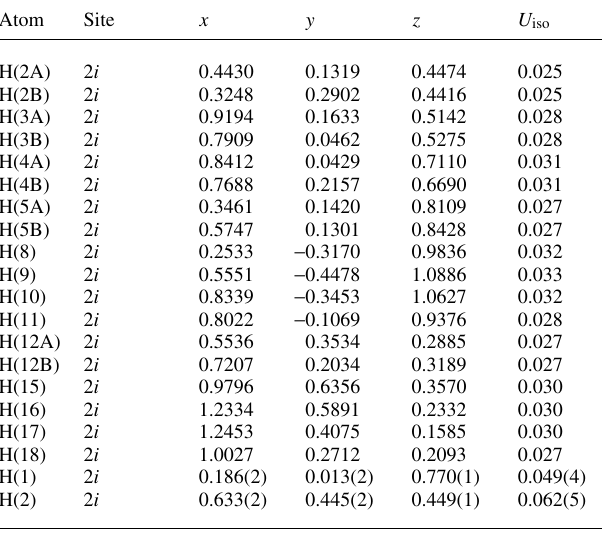
Table 2. Atomic coordinates and displacement parameters (in Å 2 )